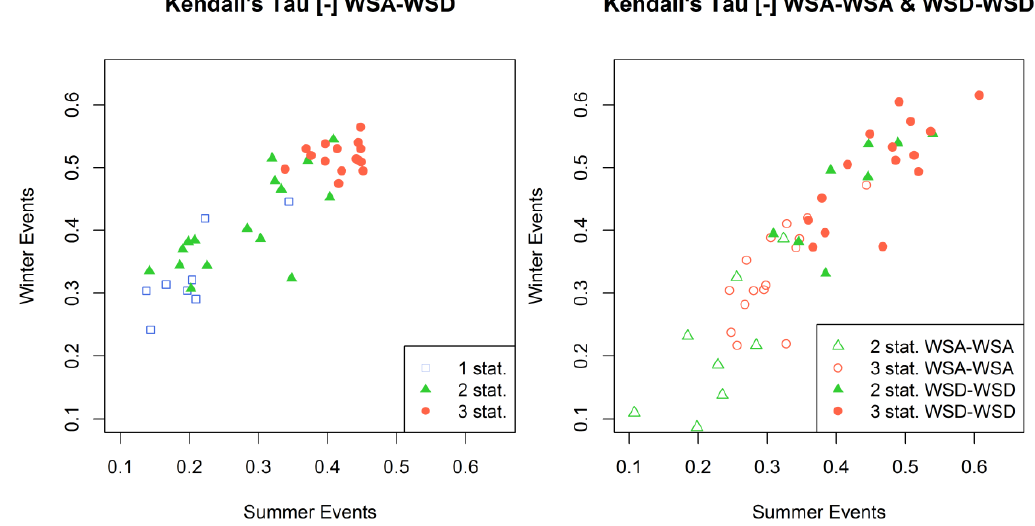
Figure 5. Dependence between event characteristics according to their occurrence in one, two, or three stations simultaneously for all